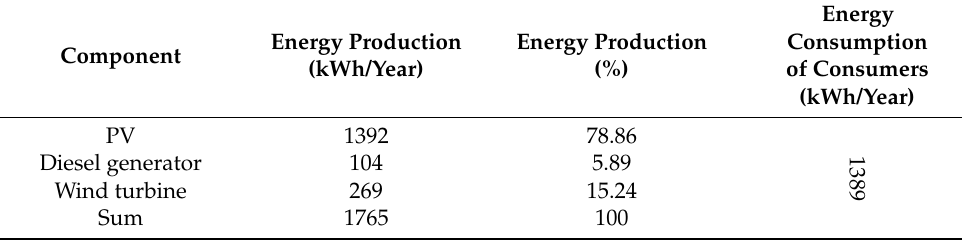
Figure 12. The waveforms for the iHOGA simulator. Like in the case of the HOMER simulator, a reduction in the emissions of carbon di- oxide, carbon monoxide, unburned hydrocarbons, etc., was obtained using renewable en- ergy compared to the emissions produced by conventional systems. The results for pollu- tant emissions (carbon dioxide and carbon monoxide) are presented in Table 9. Table 9. Pollutant emissions (iHOGA). Emissions